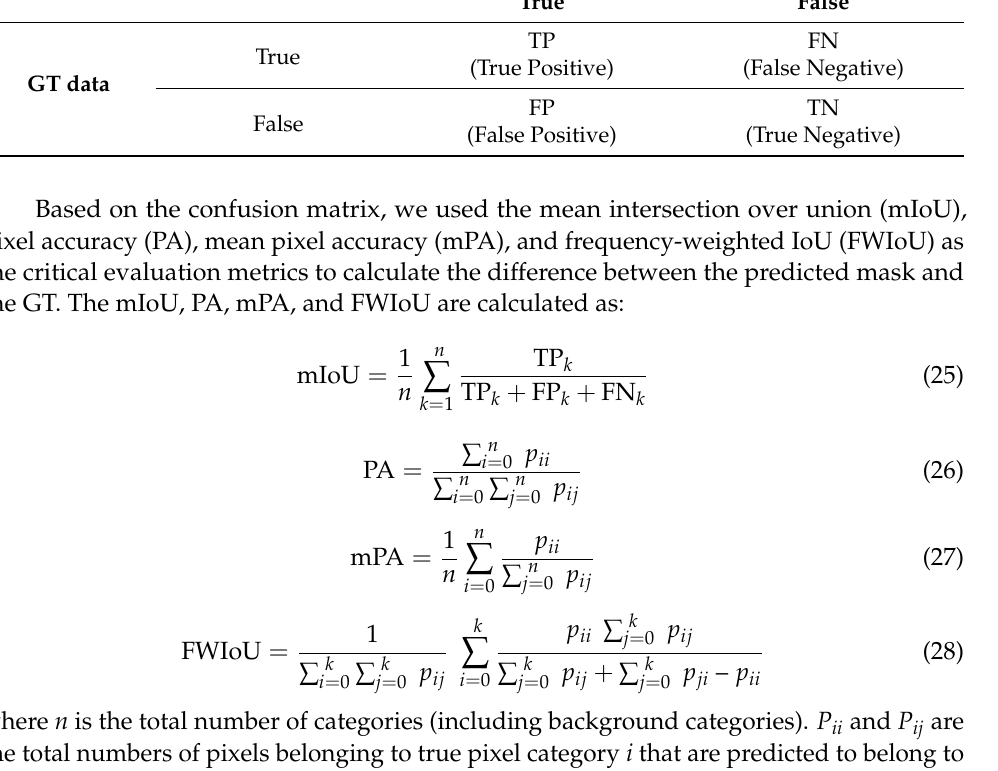
Predicted Label True False